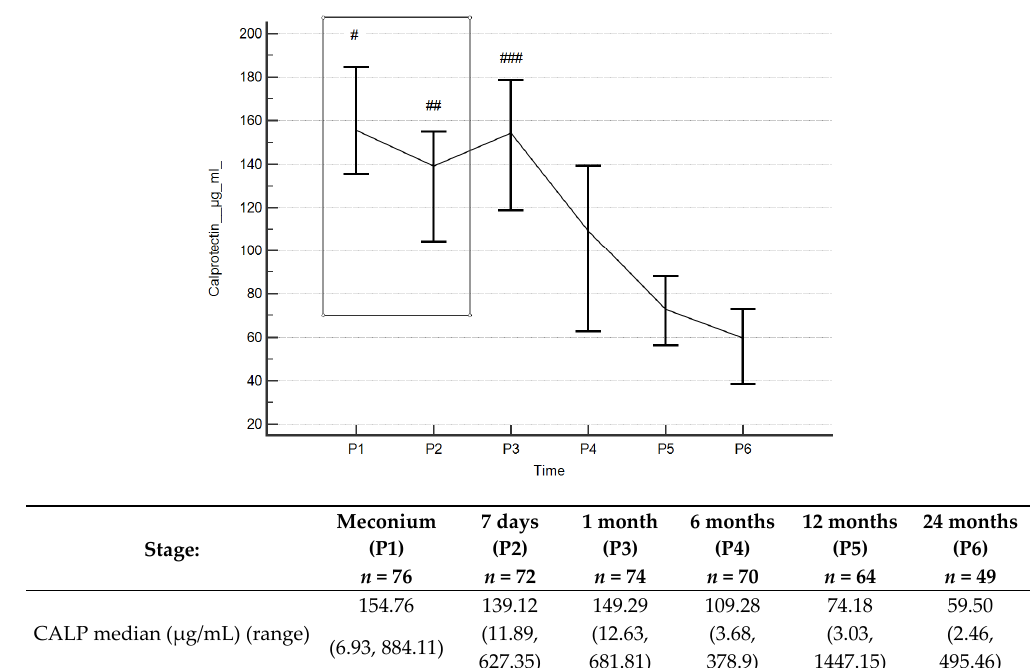
Figure 3. Calprotectin (CALP) concentrations (median) over time. Legend: Error bars represent 95% confidence intervals for medians. For Kruskall–Wallis test p < 0.000001. Conover’s post-hoc analysis: